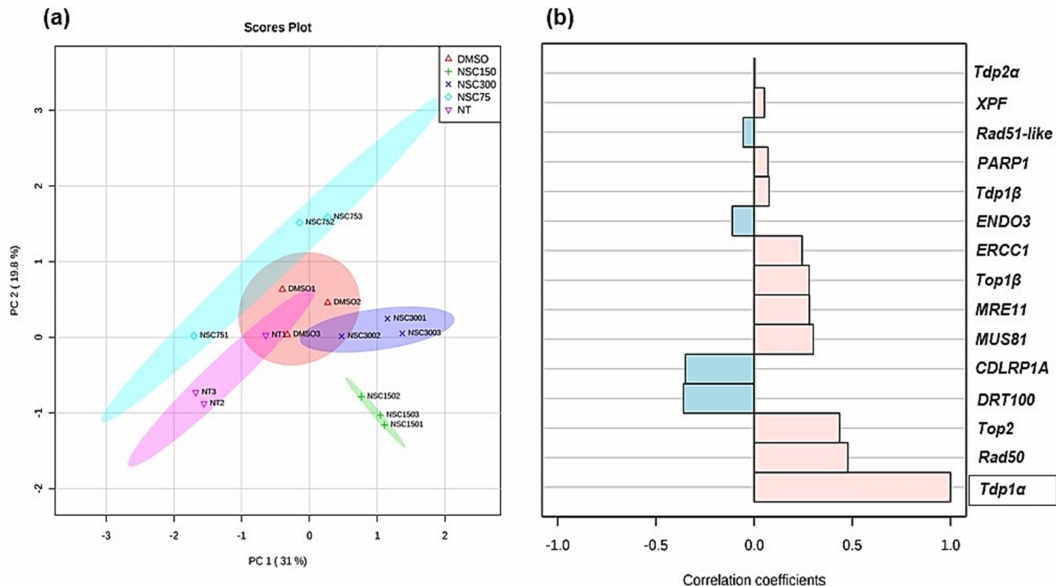
Figure 6. Correlation analysis of gene expression data in M. truncatula calli in presence/absence of NSC120686. ( a ) Principal component analysis 2D score plot. ( b ) Correlation pattern searching performed using the Tdp1 α gene expression as the defining feature. Graphics were generated using the MetaboAnalyst (http://www.metaboanalyst.ca) online